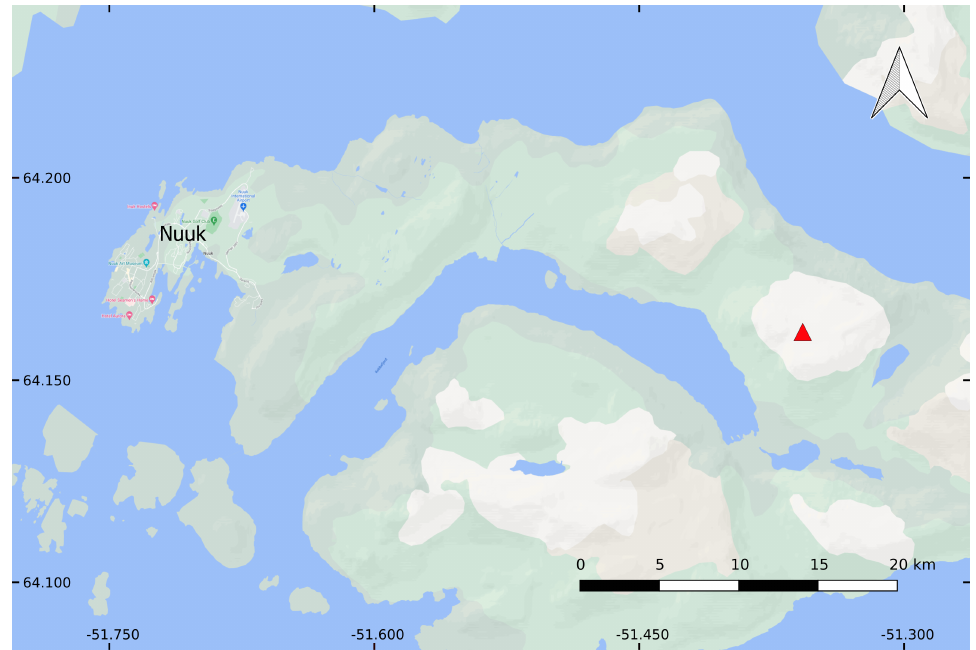
Figure 1. Map of the area including Nuuk and the weather station. The red triangle marks the position of the weather station (NUK-K). Map data c (cid:13) 2015